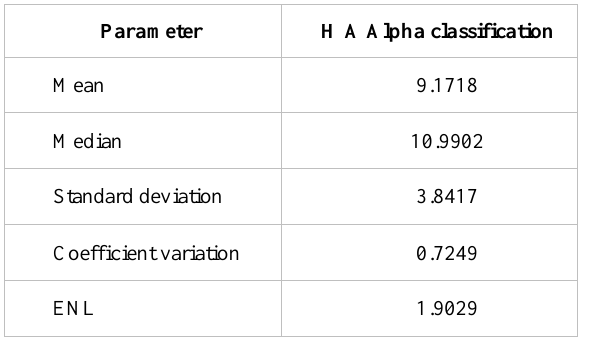
Table 1. Microwave RADARSAT-2 SAR statistical parameters